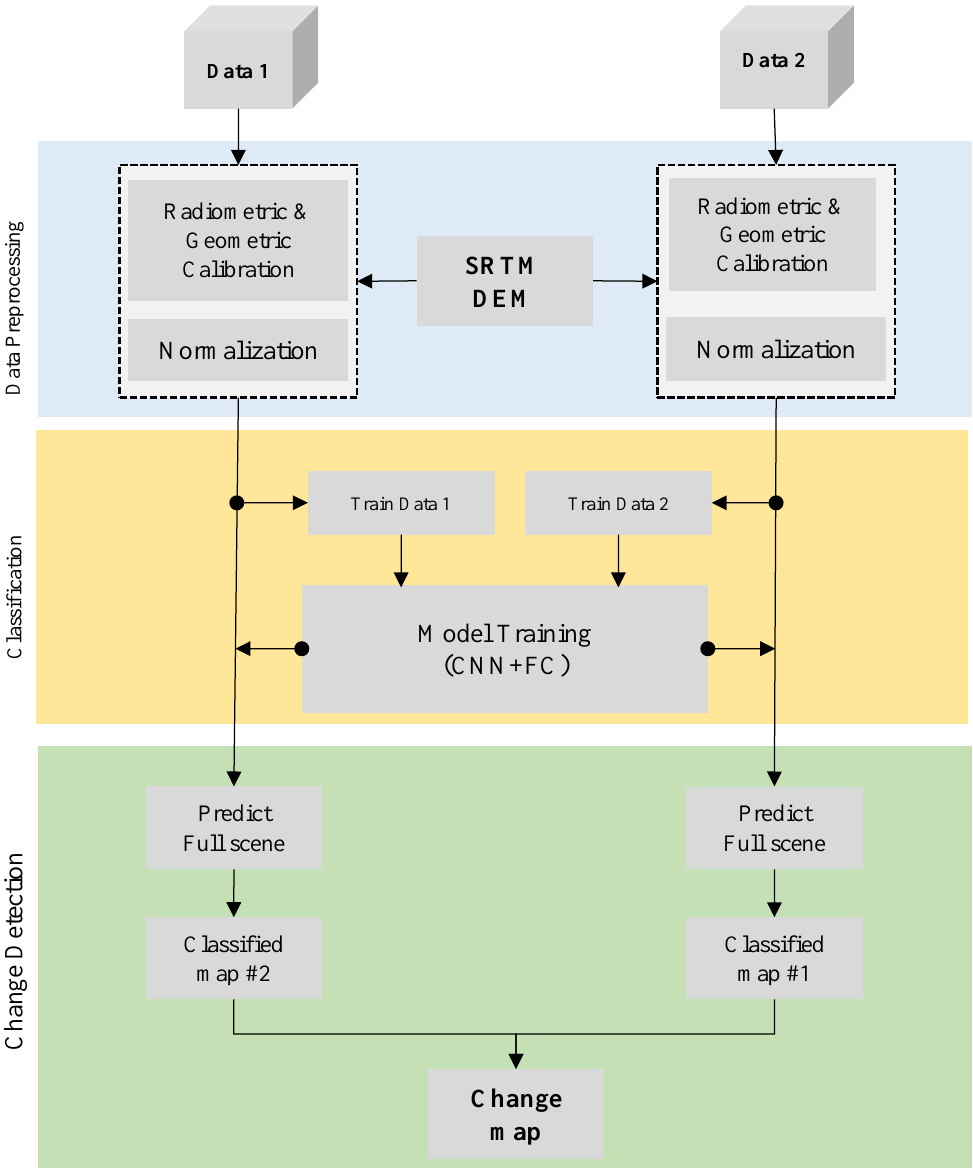
Figure 2. Flowchart of the proposed method